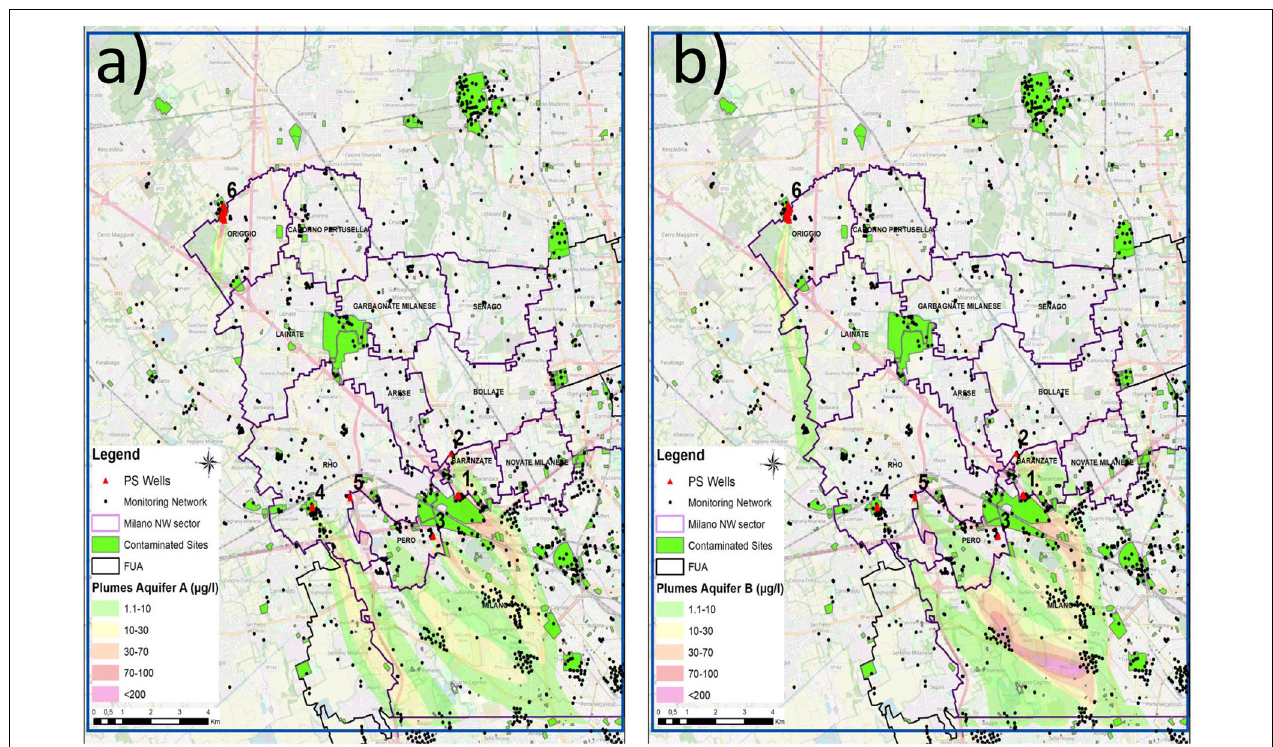
FIGURE 8 | PS related plumes simulation selected by the CA in (a) the shallow aquifer and (b) the semiconfined aquifer.